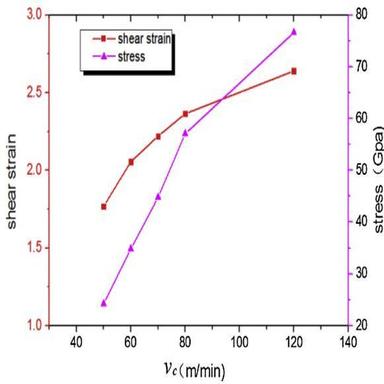
Shear strain and stress at different speeds.